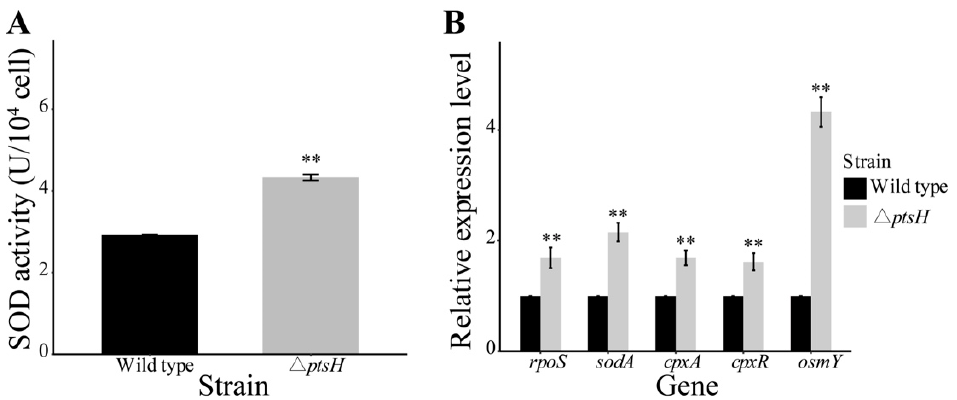
Figure 6. SOD activity ( A ), transcription levels of genes that were related with oxidative and osmotic stress ( B ) in the WT strain and Δ ptsH mutant. ** p < 0.01 compared to the WT strain.